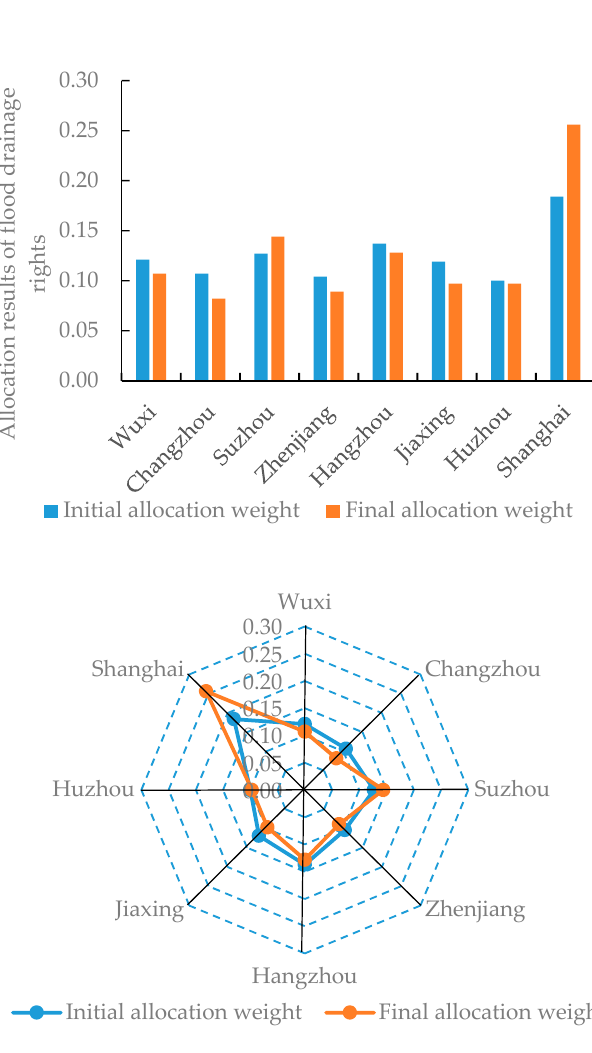
Figure 6. Allocation of flood drainage rights in each administrative region.